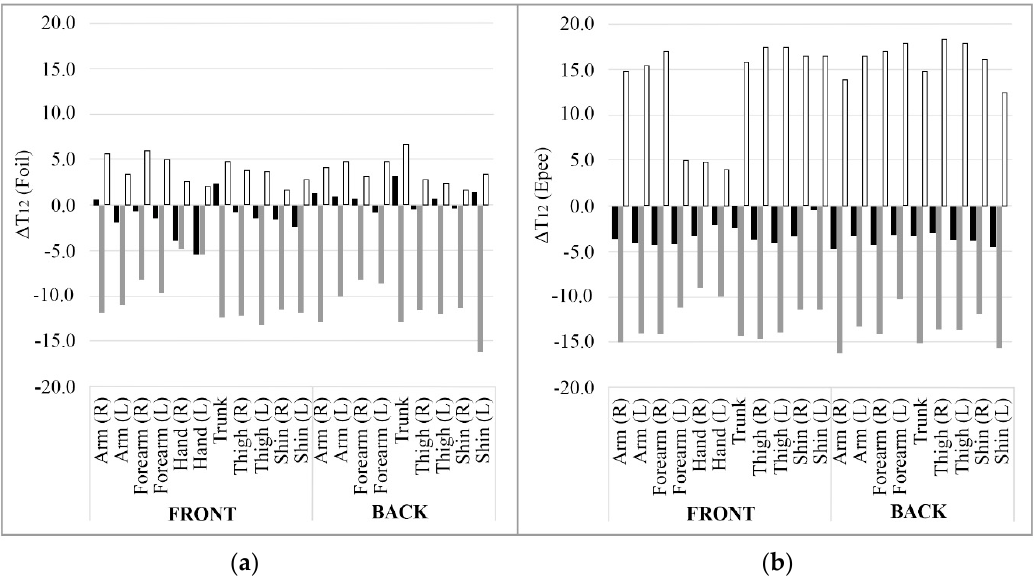
Figure 3. Temperature difference Δ T 12 on the front and the back part of the body for foil ( a ) and epee ( b ) fencers. In black veteran fencers (ID 4 for foil, ID 7 for epee), in grey national fencers (ID 3 for foil, ID 5 for epee) and in white international fencers (ID 1 for foil, ID 8 for epee).